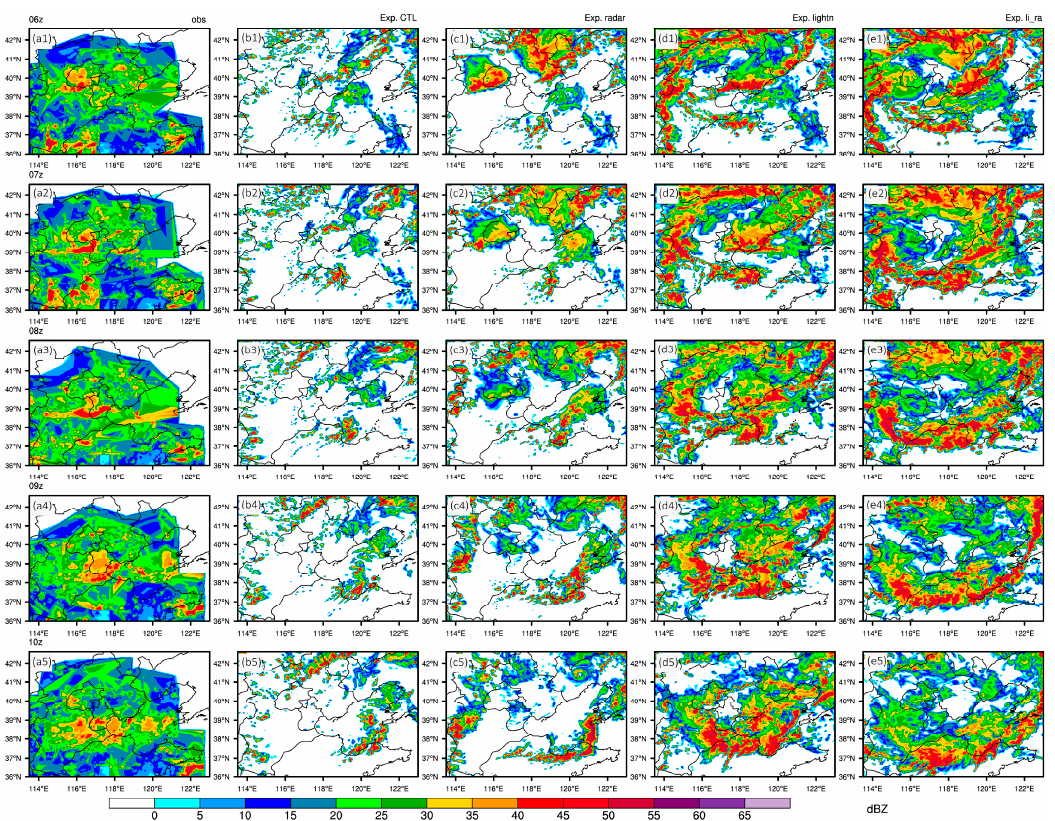
Figure 7. Forecast composite maximum reflectivity (dBZ) of the four experiments from 0600 UTC to 1000 UTC. Panels ( a1 – a5 ) show observed maximum reflectivity; and panel ( b – e ) show the maximum reflectivity of Exp. CTL, Exp. radar, Exp. lightn and Exp. li_ra at each of these 5 h, respectively (unit: dBZ).